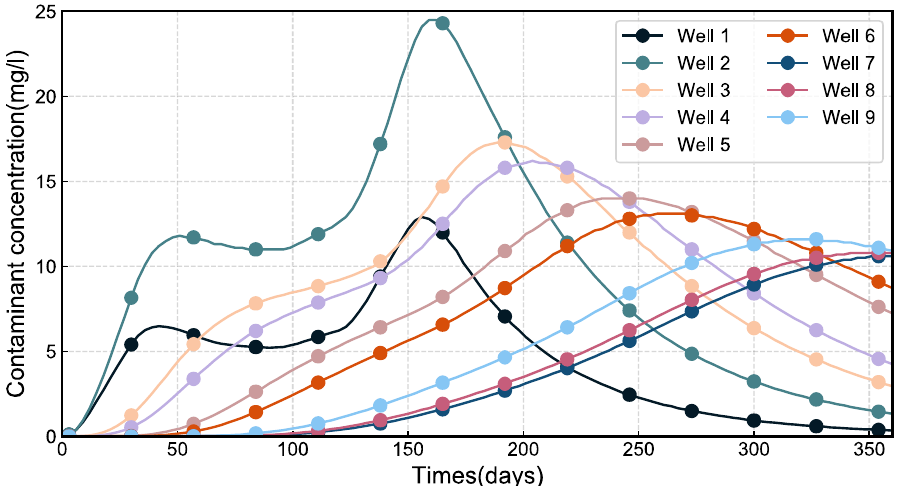
Figure 5. Observed data of contaminant concentration at each monitor well.